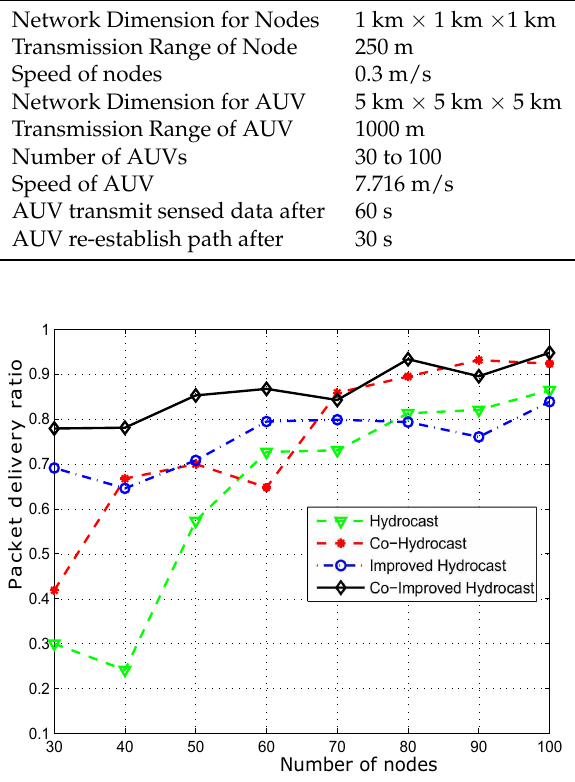
Figure 12. Successfully transmitted data packets to